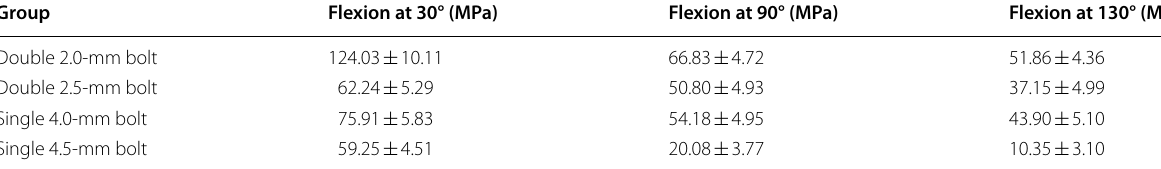
Table 1 Comparing the distribution of maximal principal stress on the fixation bolt between groups Group